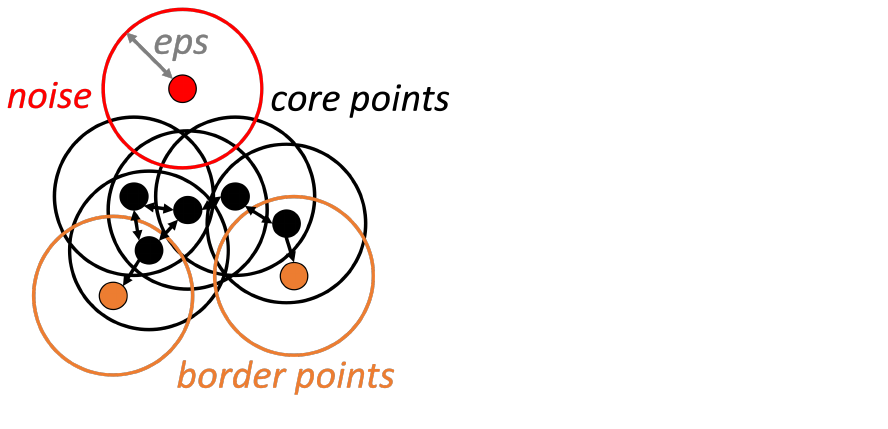
Figure 4. Parameters and process of DBSCAN. DBSCAN begins by selecting a point randomly and checks whether the selected point is a core point (if it contains at least minpoints number of minimum points in its eps -neighborhood). It assigns each non-core point to the nearest cluster, or otherwise assigns it to noise